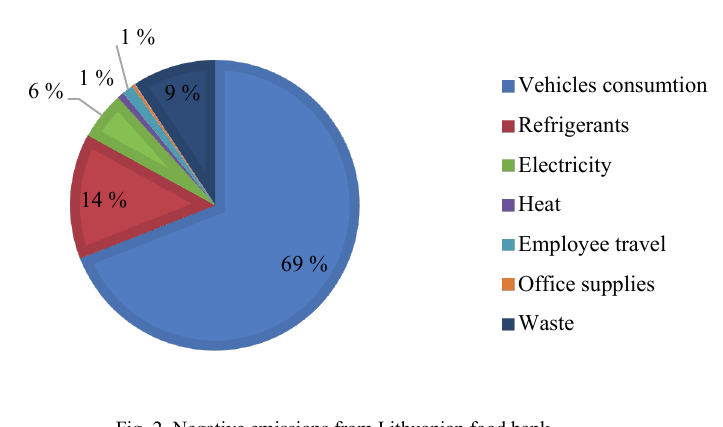
Fig. 2. Negative emissions from Lithuanian food